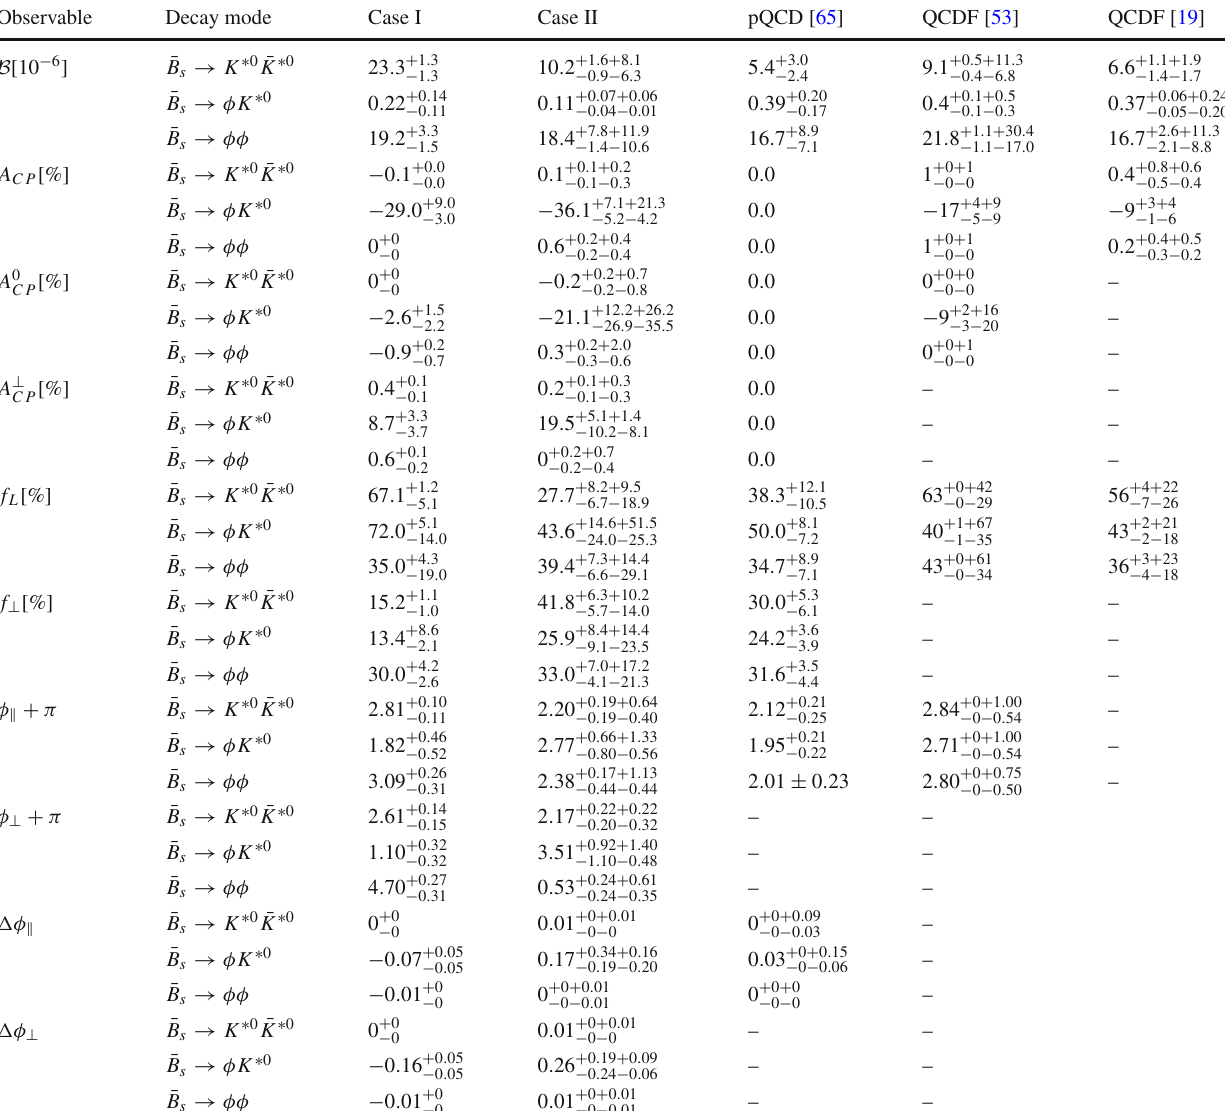
Table 3 Theoretical results for the measured ¯ B s → K ∗ 0 ¯ K ∗ 0 , φ K ∗ 0 and φφ decays